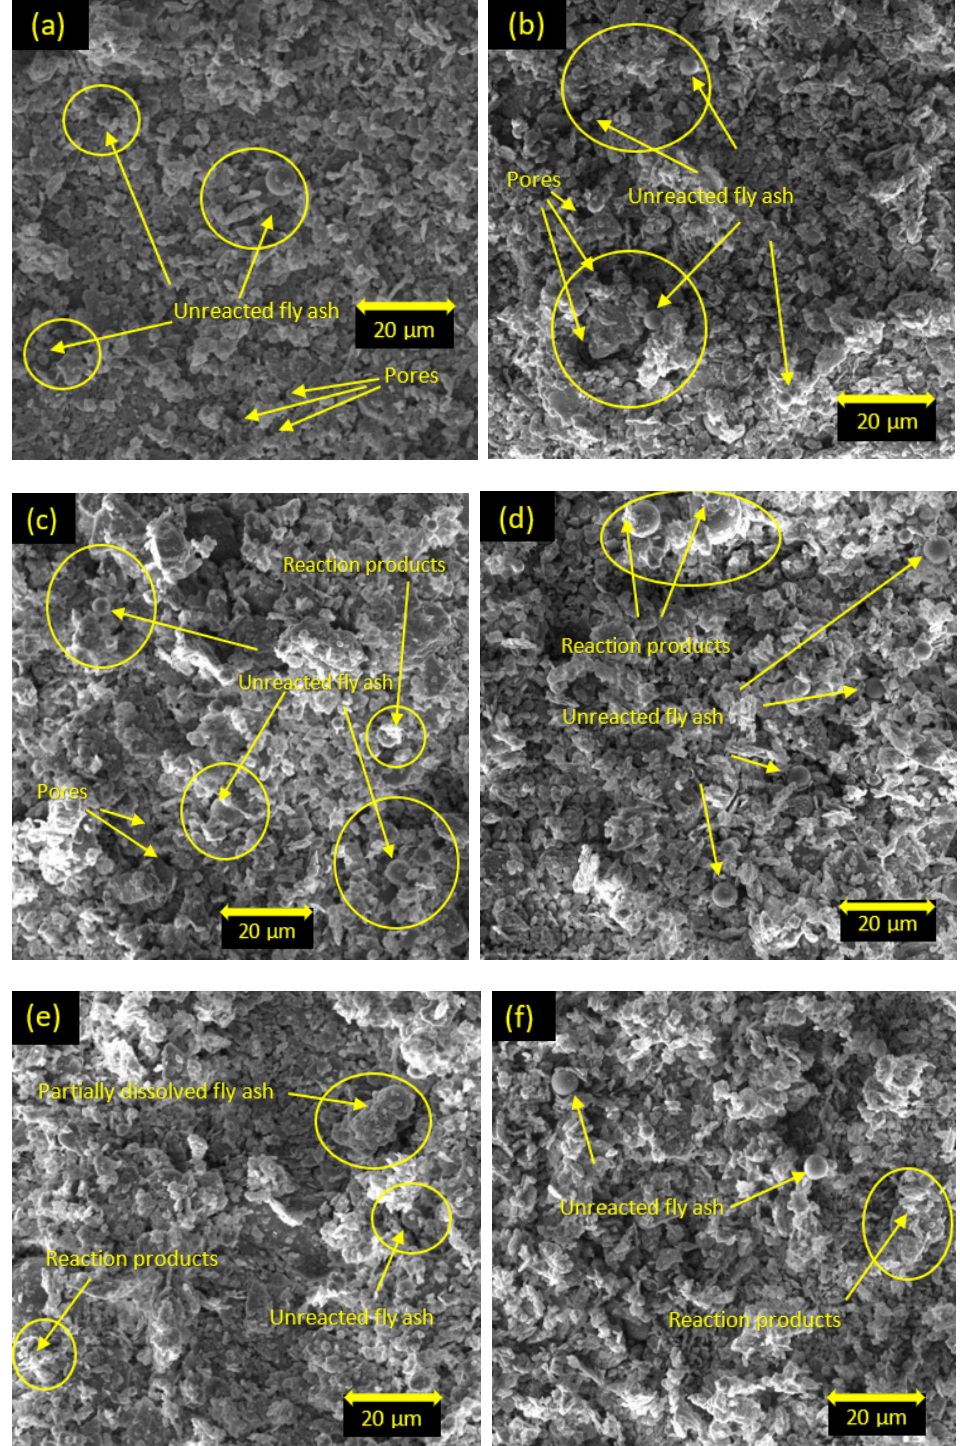
Figure 16. SEM images of soil stabilized with class F fly ash: ( a ) 15% F, one day of curing; ( b ) 25% F, one day of curing; ( c ) 15% F, seven days of curing; ( d ) 25% F, seven days of curing; ( e ) 15% F, 28 days of curing; ( f ) 25% F, 28 days of curing.